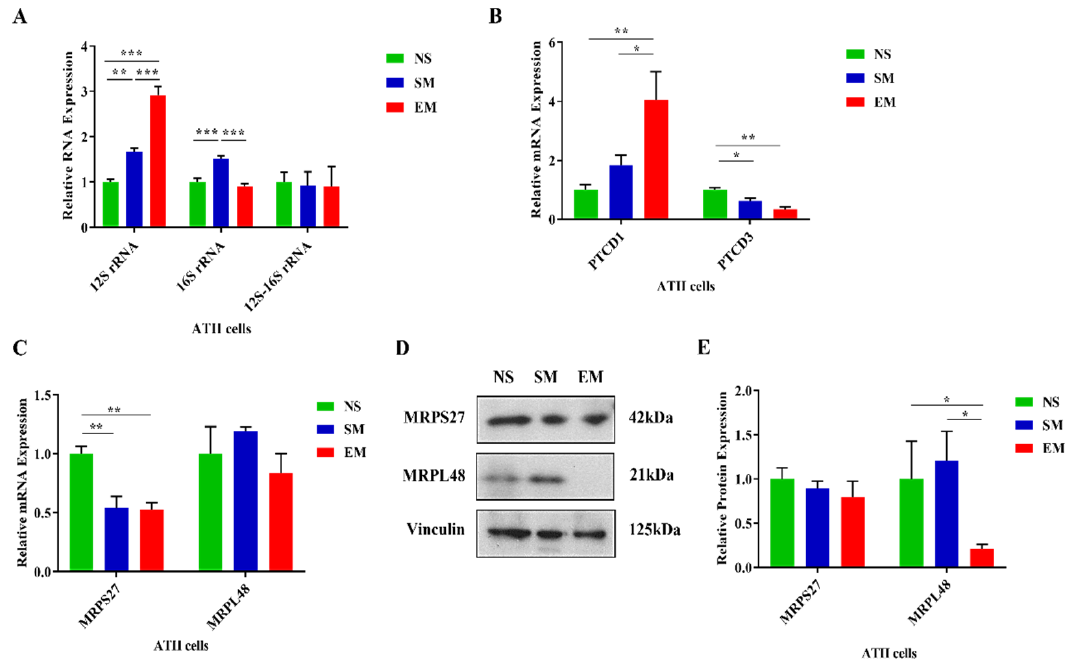
Figure 4. Dysregulated expression of mitoribosome components, PTCD1, and PTCD3 in ATII cells in emphysema. ( A ) The expression of mitoribosome 12S, 16S, and the junction 12S–16S rRNA was assessed using RT-PCR in ATII cells isolated from nonsmokers (NS), smokers (SM), and emphysema patients (EM). mRNA expression of PTCD1 and PTCD3 ( B ) and MRPS27 and MRPL48 ( C ) was as- sessed by RT-PCR. ( D ) MRPS27 and MRPL48 protein levels were evaluated by Western blotting. ( E )